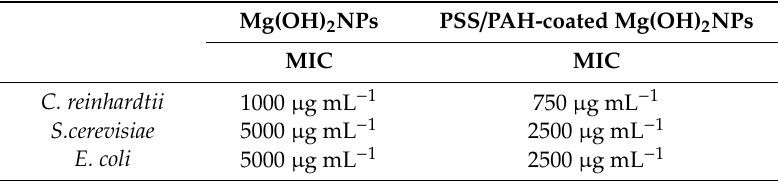
Table 1. Minimum inhibitory concentration (MIC) of bare Mg(OH) 2 NPs and PSS / PAH-coated Mg(OH) 2 NPs against C. reinhardtii , S. cerevisiae and E. coli